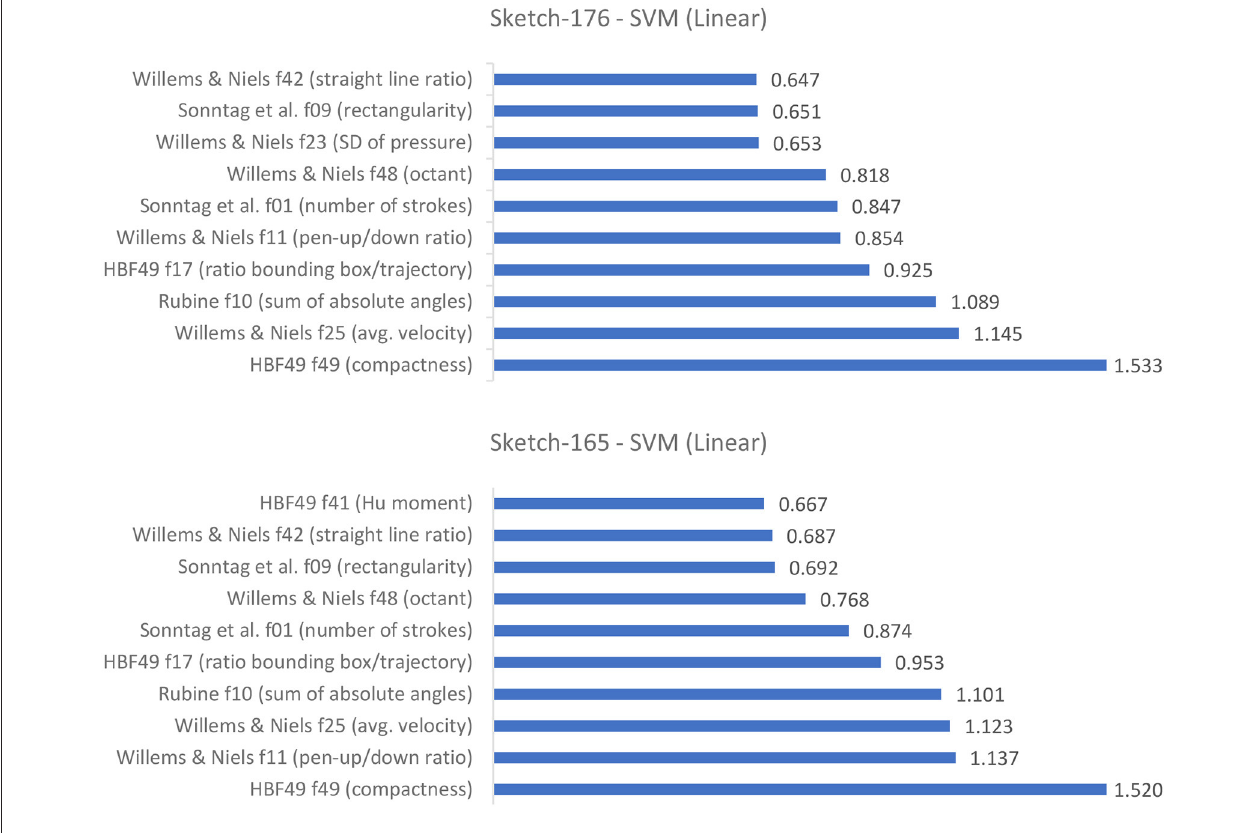
FIGURE 12 | Average weights assigned to the input features of the linear SVMs (top